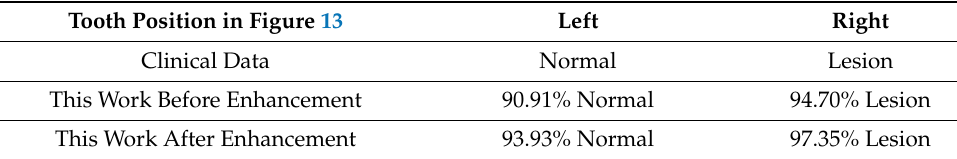
Figure 13. The example for validation with cropping image. Table 8. Comparison of the clinical data and the resulting image.